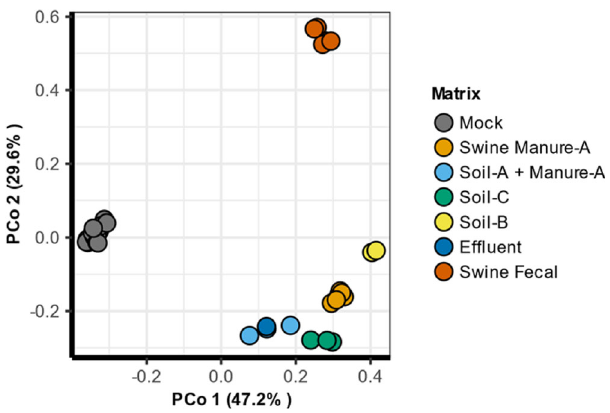
Fig. 4 Ordination of DARTE-QM samples. Principal coordinate analysis (PCoA) based on Bray – Curtis distances of the resistomes produced from DARTE-QM samples passing all QC-